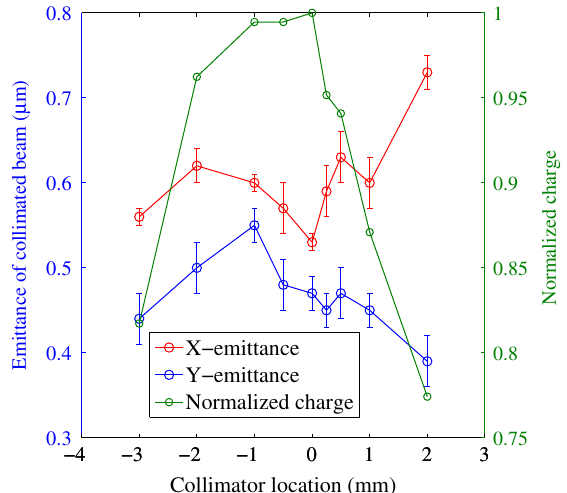
FIG. 8. Measured x - and y -emittance of collimated slice beam along the long bunch with g ¼ 0 . 5 mm of collimator